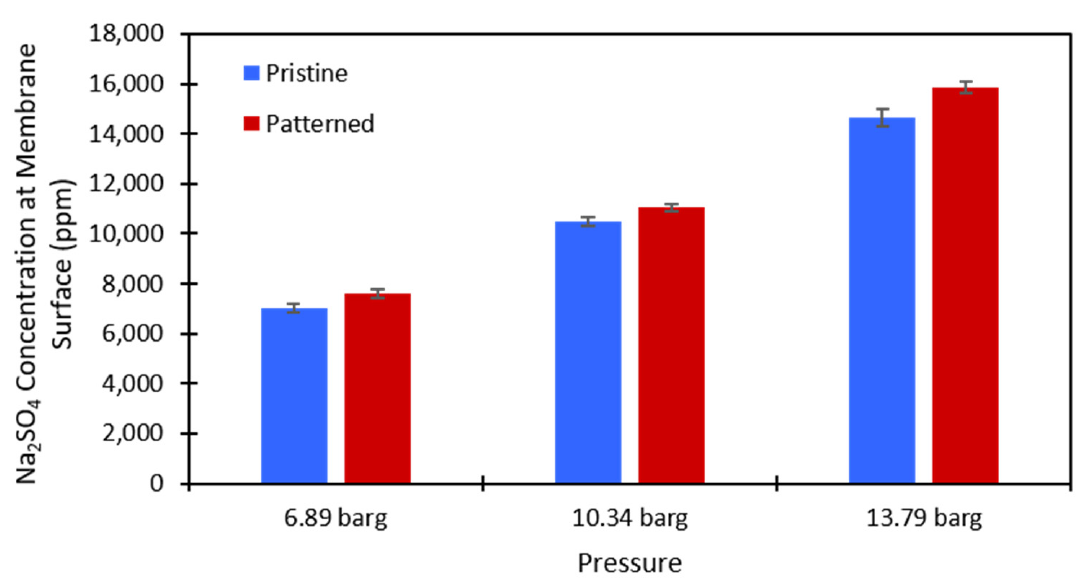
Figure 7. Calculated values of the Na 2 SO 4 concentration at the membrane surface for the 2000 ppm feed stream. Blue is the pristine NF270 membrane, and red is the patterned NF270 membrane. The error bars represent one standard deviation among at least three membrane samples.